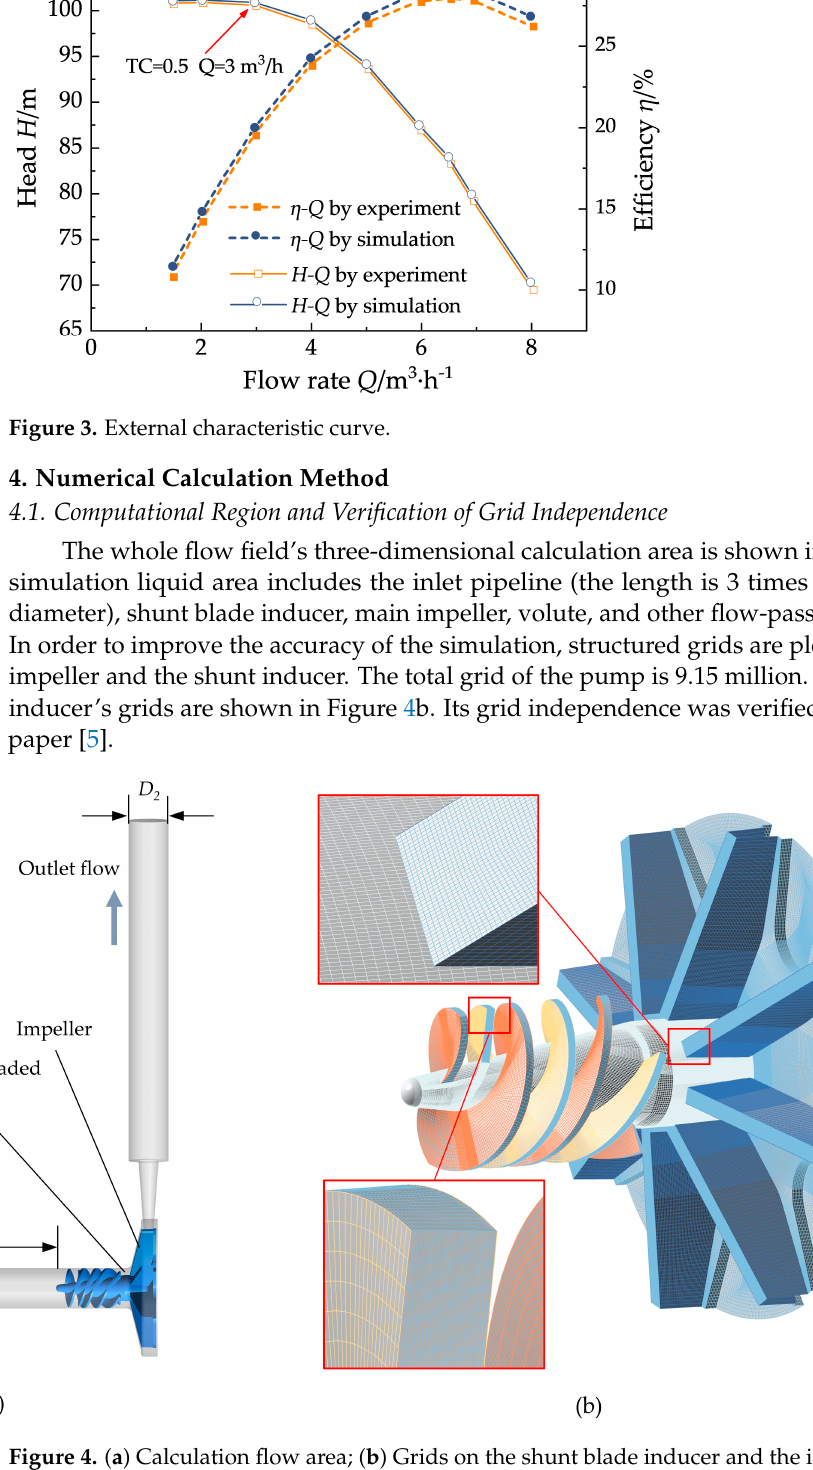
Figure 4. ( a ) Calculation flow area; ( b ) Grids on the shunt blade inducer and the impeller.